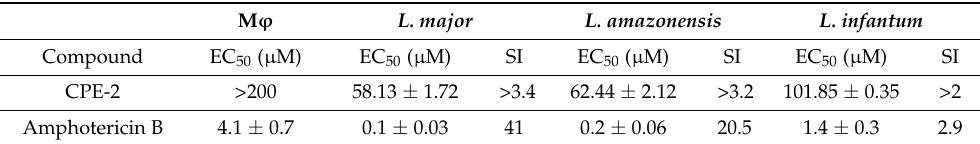
Table 5. EC 50 and SI (selectivity index) of selected compound and amphotericin B on murine bone marrow derived macrophages (M ϕ ) and Leishmania spp. promastigotes at 48 h post treatment. M ϕ L.